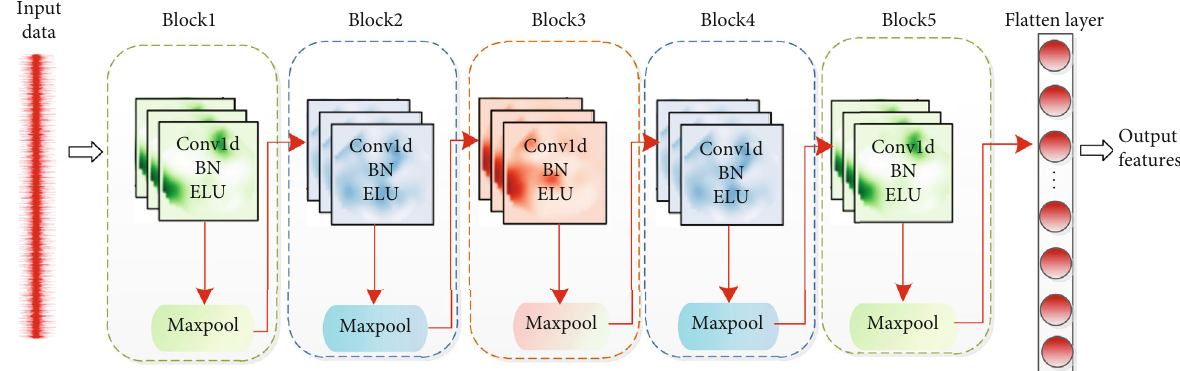
Figure 3: Architecture of CNN-based feature extractor.